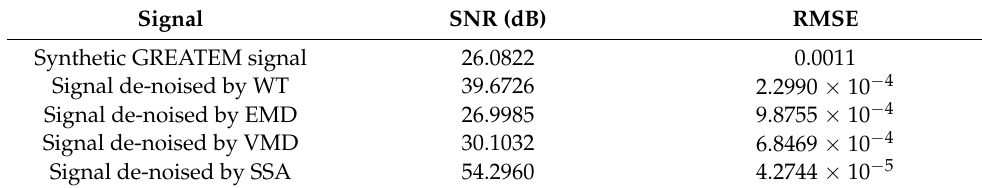
Table 1. Comparison of indexes for different algorithms to eliminate the higher harmonic noise.